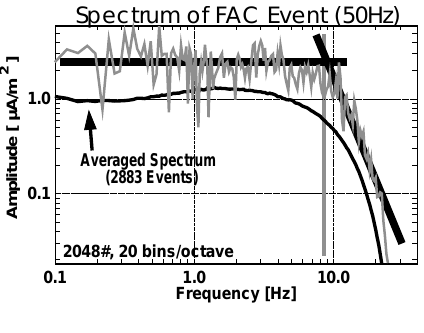
Fig. 3. Single event and average spectrum of 50-Hz current bursts.